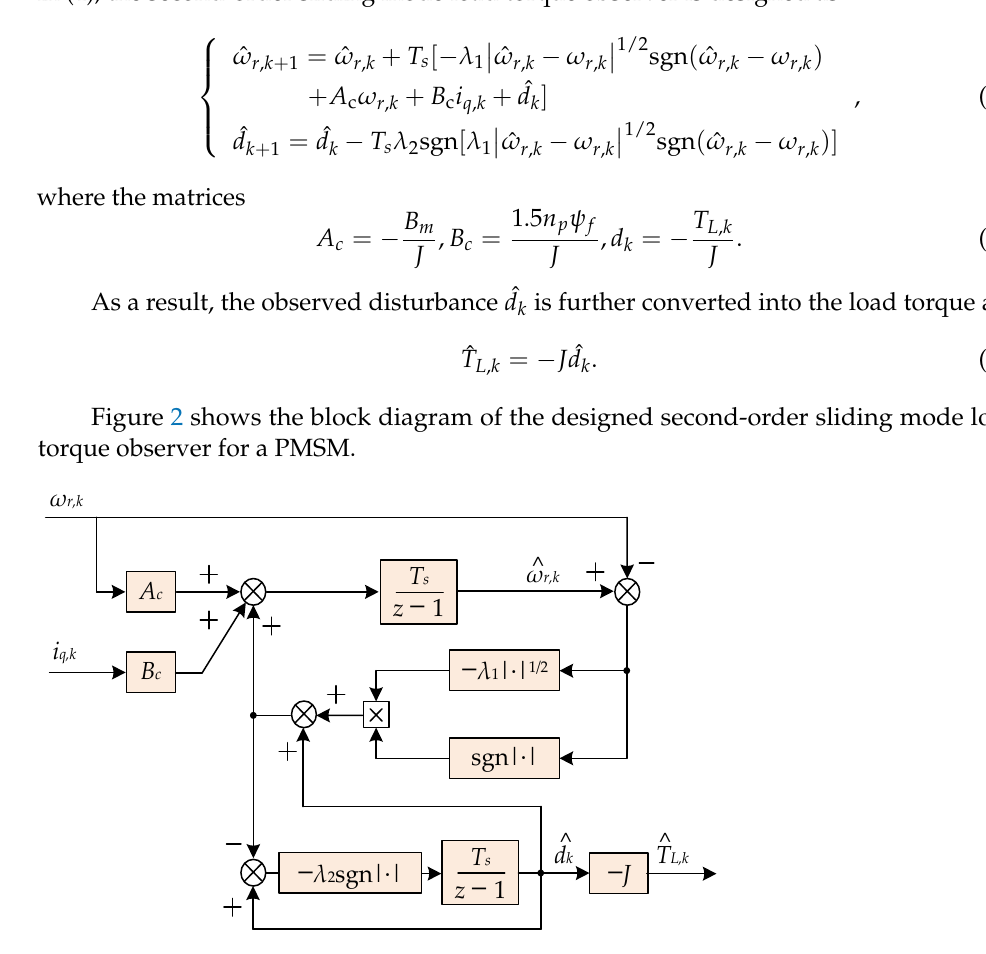
Figure 2. Block diagram of the second-order sliding mode load torque observer. Finally, the overall block diagram for implementation of the proposed cascade-free MPDSC scheme for PMSM drives is shown in Figure